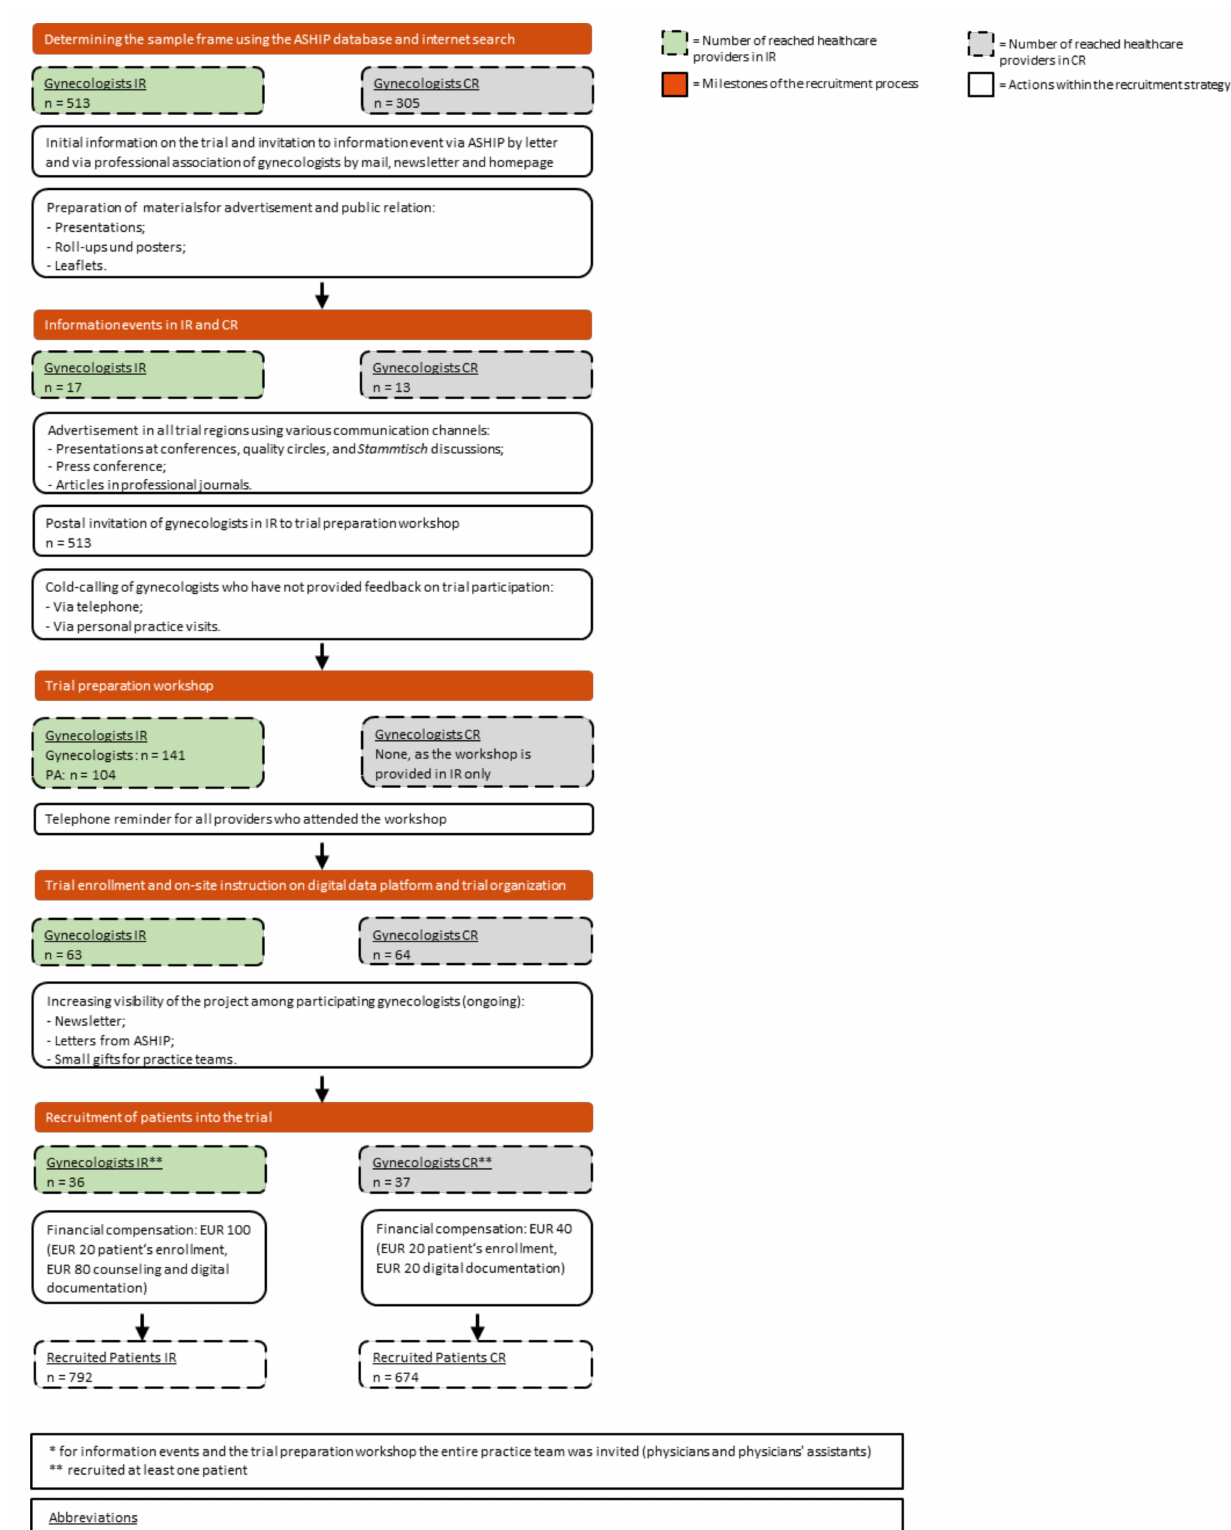
Figure 1. Flowchart for the recruitment process in the GeMuKi